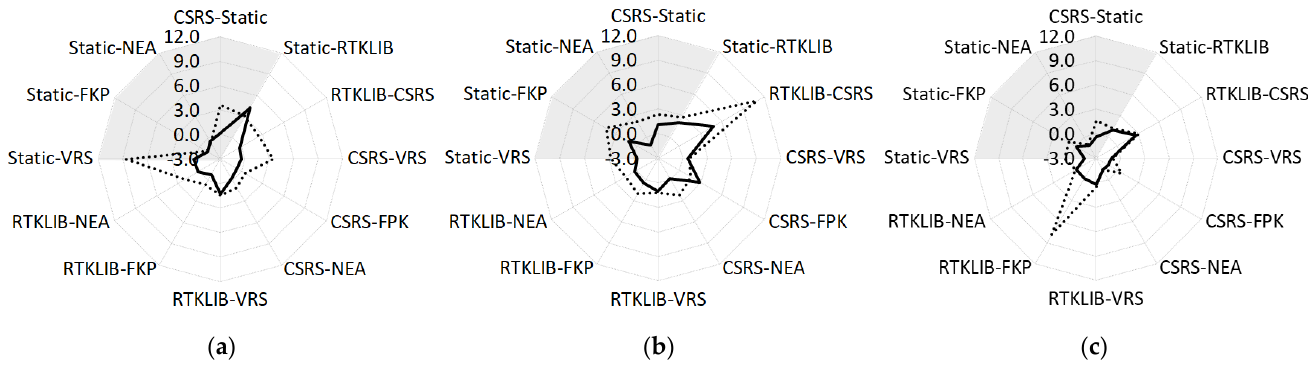
Figure 6. Kurtosis, K: ( a ) Δ N; ( b ) Δ E; ( c ) Δ h differences, pre and post outliers’ removal (dashed and continuous lines, respectively).